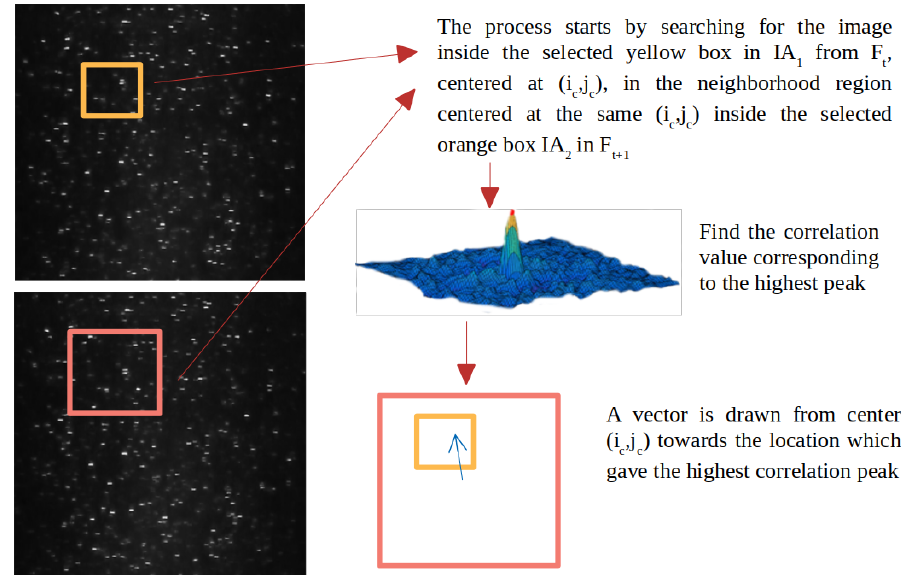
Figure 2. 2D Correlation Algorithm. The upper image with particles on the left is F t . The lower image on the left is F t + 1 . The region with the light orange borders in the upper image is IA 1 . The region with the pink borders in the lower image is IA 2 . The 3D plot on the right plots all 2D correlation values. The highest peak helps to estimate the general flow